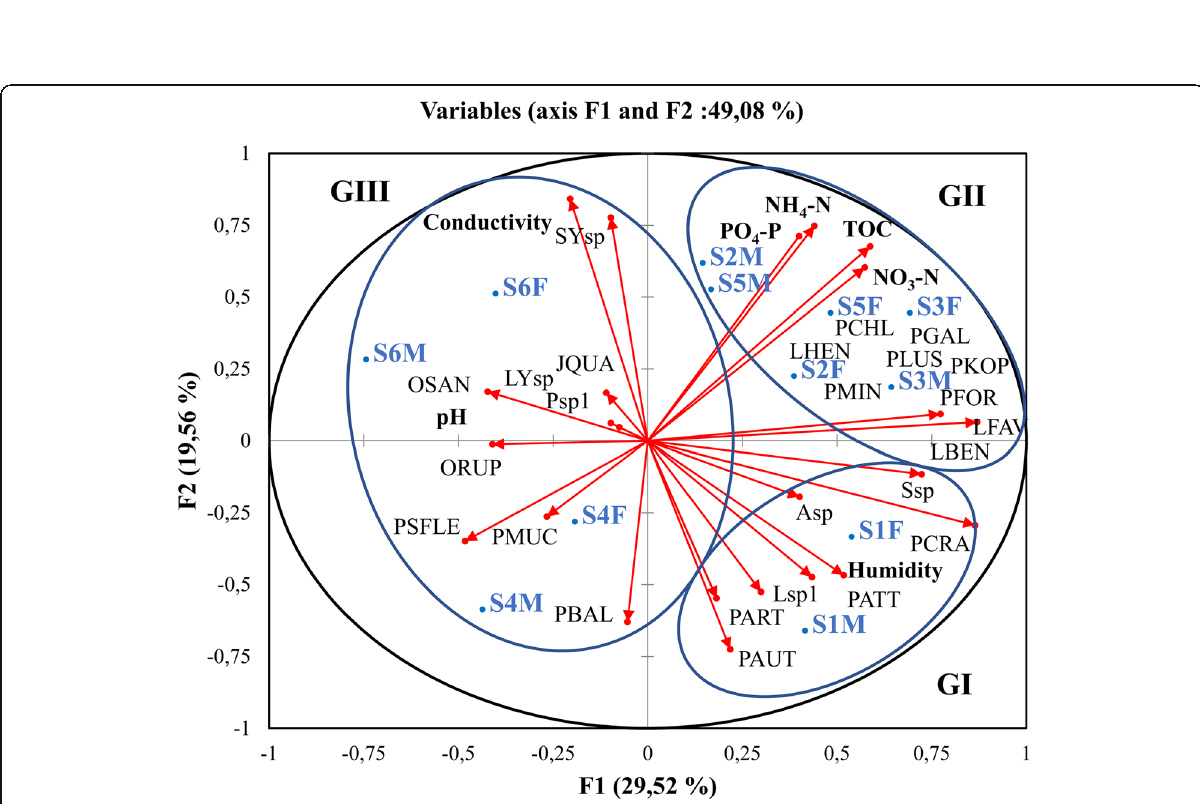
Fig. 5 PCA ordination analysis and projection of variables (physicochemical parameters and cyanobacteria taxa) and sampling sites (in blue) on the factoriel level (1 × 2). The PCA ordinations were constructed from a distance matrix of environmental variables. The visually categorized 3 groups in the PCA plot based on the arrow direction and the geometric angles between them (the more variables are correlated, the more their arrows point in the same direction; thus, the correlation coefficient is symbolized by the geometric angles between the arrow). Circles show selected groups. Species abbreviations are given in Table